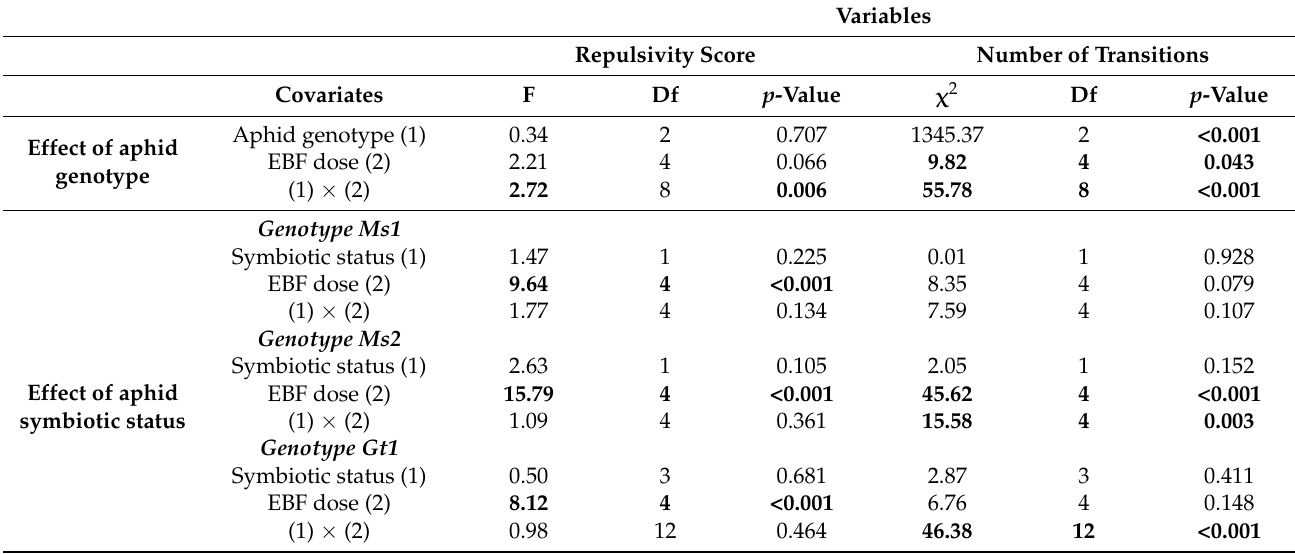
Table 2. Significance of the covariates included in the statistical models explaining both the repulsivity score and the number of transitions in the olfactometer at different E- β farnesene (EBF) doses in Acyrthosiphon pisum genotypes carrying or not carrying Hamiltonella defensa. Bold values highlight significant effects. Df: degrees of